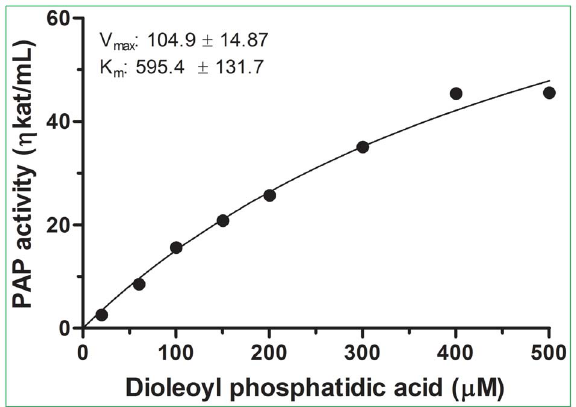
Figure 6. Kinetcis of PAP enzyme activity. PAP activity vs. substrate concentration. The assay was performed at 53 u C, pH 6.5 for 10 min using various concentrations of DPA. The data presented are the mean of 2 assays for each